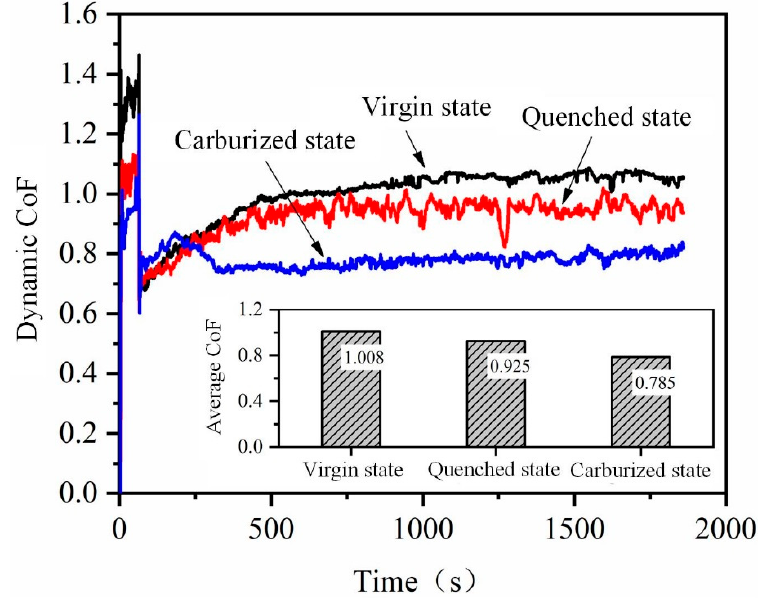
ffi cient of friction (CoF) of the tribo-pairs under di ff erent material Figure 6. The coefficient of friction (CoF) of the tribo-pairs under different material states. Figure 6. The coe